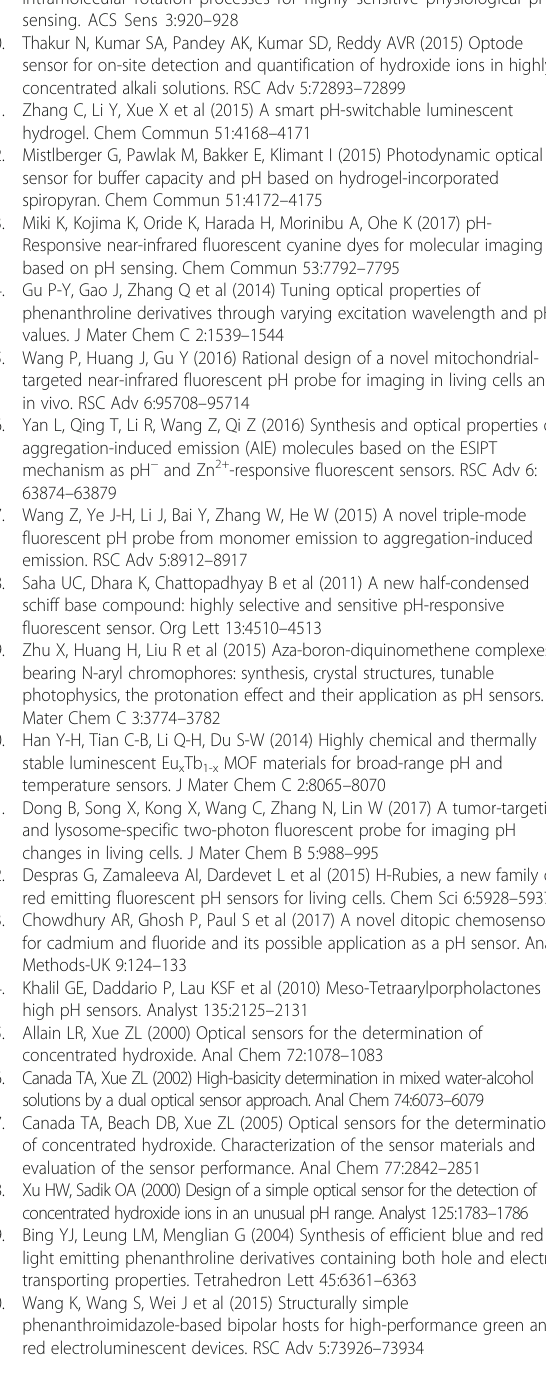
S15. The 1 H NMR spectrum of TEG-OTs. Figure S16. The 13 C NMR spectrum of TEG-OTs. Figure S17. The mass spectrum of TEG-OTs. Figure S18. The 1 H NMR spectrum of 2TEG-Bd. Figure S19. The 13 C NMR spectrum of 2TEG-Bd. F igure S20. The mass spectrum of 2TEG-Bd. Figure S21. The 1 H NMR spectrum of BMIP. Figure S22. The 13 C NMR spectrum of BMIP. Figure S23. The mass spectrum of BMIP. (DOCX 13682 kb) Abbreviations DMSO: Dimethyl sulfoxide; IP: